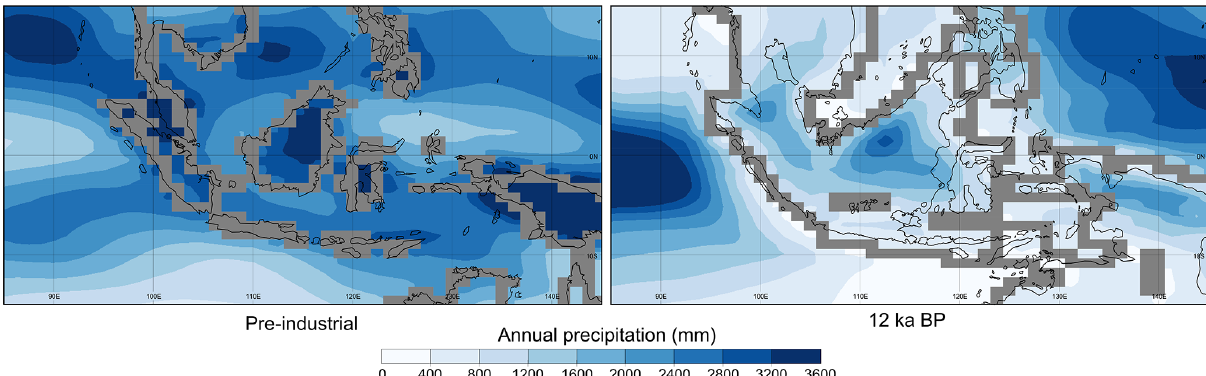
Figure 3. Comparison of annual mean total precipitation (mmyr − 1 ) at PI and 12kaBP based on CESM1. The generally drier conditions are consistent with generally drier proxy evidence during the Late Glacial (e.g., Fig. 2b–d). Note that precipitation at 12kaBP shifts from the land to the sea. Seasonal precipitation is shown in Fig. S2 with almost no precipitation over most ISEA areas in NH winter. Black lines are coastlines for each period based on present day bathymetry (0m elevation for PI, − 55m for 12kaBP), and grayed out areas are partly